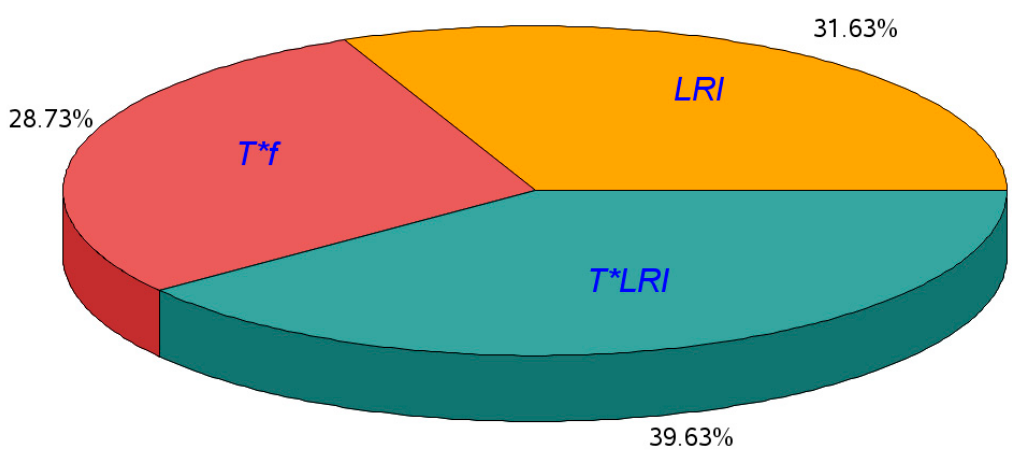
Figure 6. Distribution of the percentage of variability attributed to each effect over the variability explained by the ANOVA model.